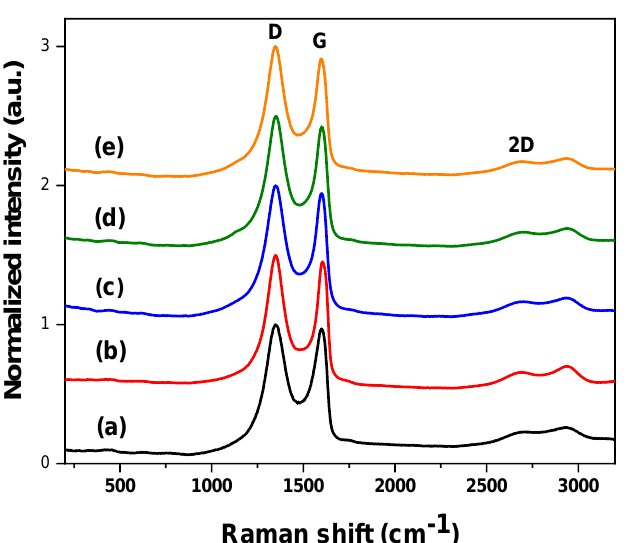
Figure 11. Comparative Raman spectra of: (a) graphene oxide and (b–e) Sn-rGO composite coatings obtained at different current densities: (b) 15 mA cm − 2 , (c) 20 mA cm − 2 , (d) 25 mA cm − 2 and (e) 30 mA cm − 2.